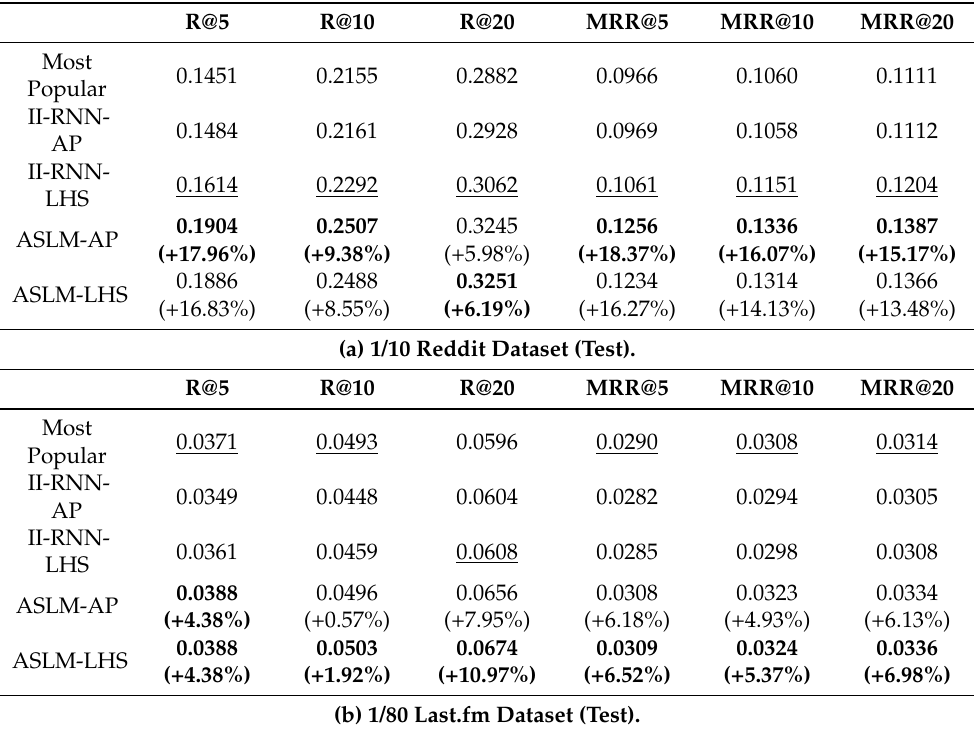
Table 2. Group B: Recall and MRR scores for the ASLM models and the baselines for the test sets in 1/10 Reddit and 1/80 Last.fm datasets.